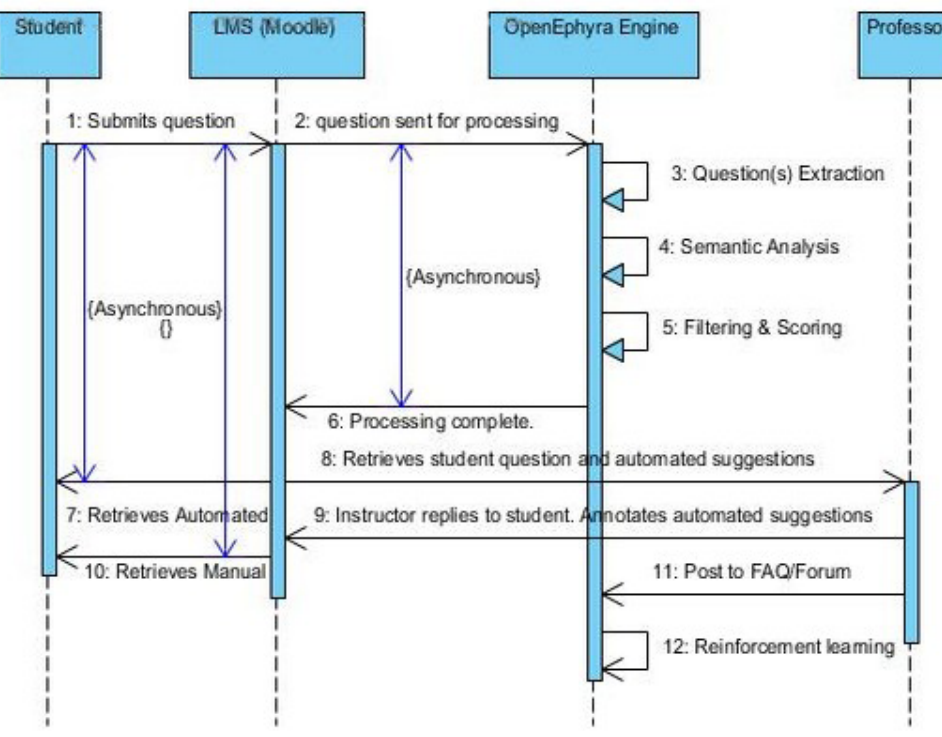
Figure 2 . Asynchronous semantic QA model (Wen, D., Cuzzola, J., Brown, L. & Kinshuk,